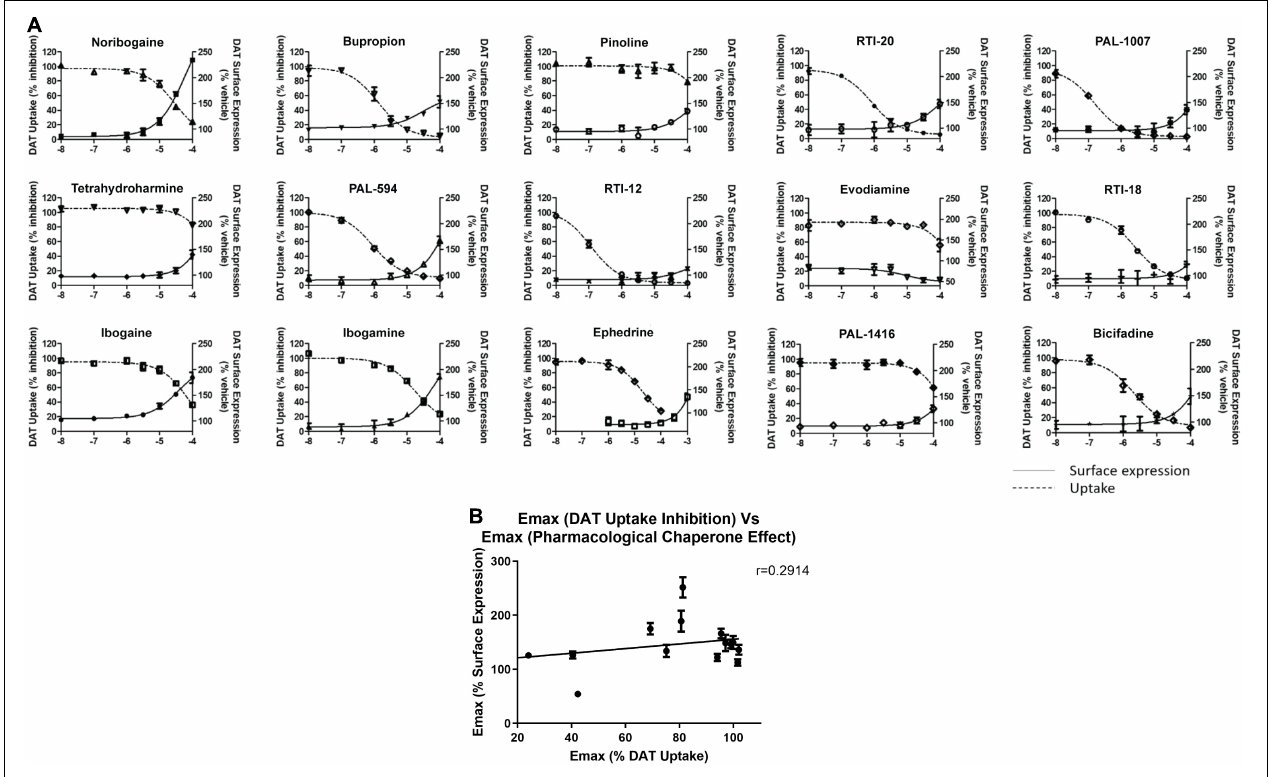
FIGURE 6 | Comparison of dopamine uptake inhibition and DAT surface expression for hit compounds. (A) Dose responses of 15 hit compounds are represented with uptake inhibition represented on the left Y -axis and surface expression on the right Y -axis. Doses used are half-log dilutions between 100 µ M and 100 nM, with 2 full log dilutions yielding 10 and 1 nM. Data were normalized to vehicle treatment. Data were fitted to one-site dose-response non-linear regression curves using GraphPad Prism. Data are means ± S.E.M. (B) Correlation graph of pharmacological chaperone E Max ( y -axis) and dopamine uptake inhibition E Max ( x -axis) of the 15 compounds in (A) . There was low correlation between pharmacological chaperone effect and dopamine uptake inhibition as demonstrated by the Pearson correlation coefficient, r = 0.2914. Data are means ±